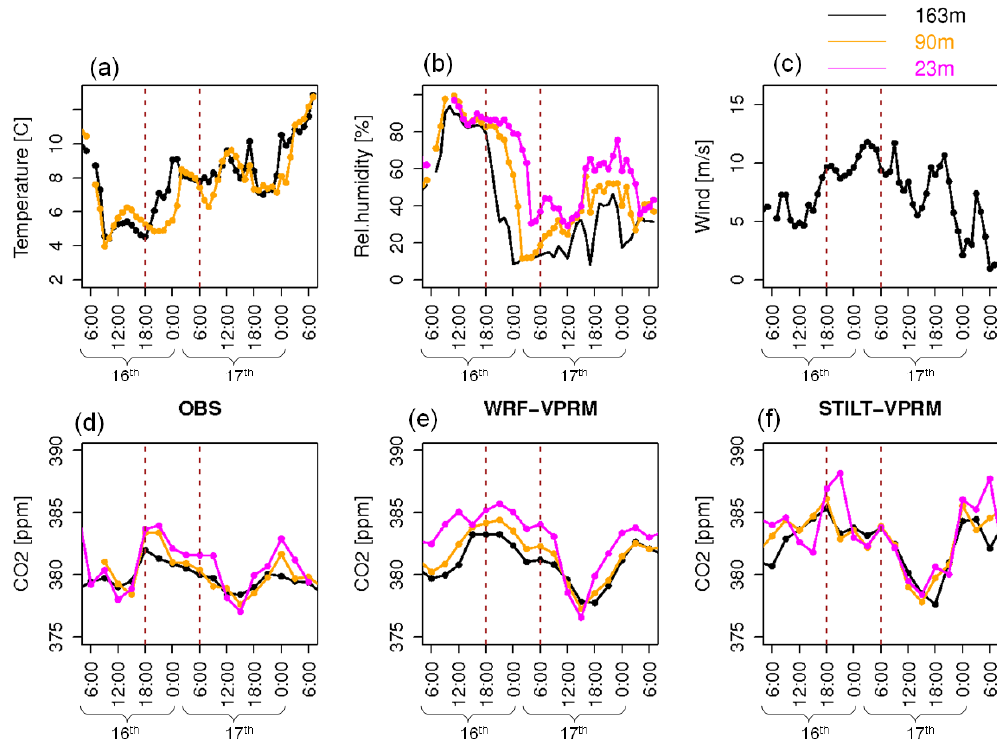
Fig. 11. Time series of meteorological parameters and CO 2 concentrations for different levels at Ochsenkopf tower site during 16–17 October 2006: (a–c) observed air-temperature, relative humidity and wind speed respectively (d–f) CO 2 concentration-observed, modeled by WRF and STILT respectively. The area between dashed brown vertical bars denotes the period under mountain wave activity. The x-axis shows hours in UTC; the horizontal extent of curly bracket at the bottom of x-axis shows the day on October 2006.